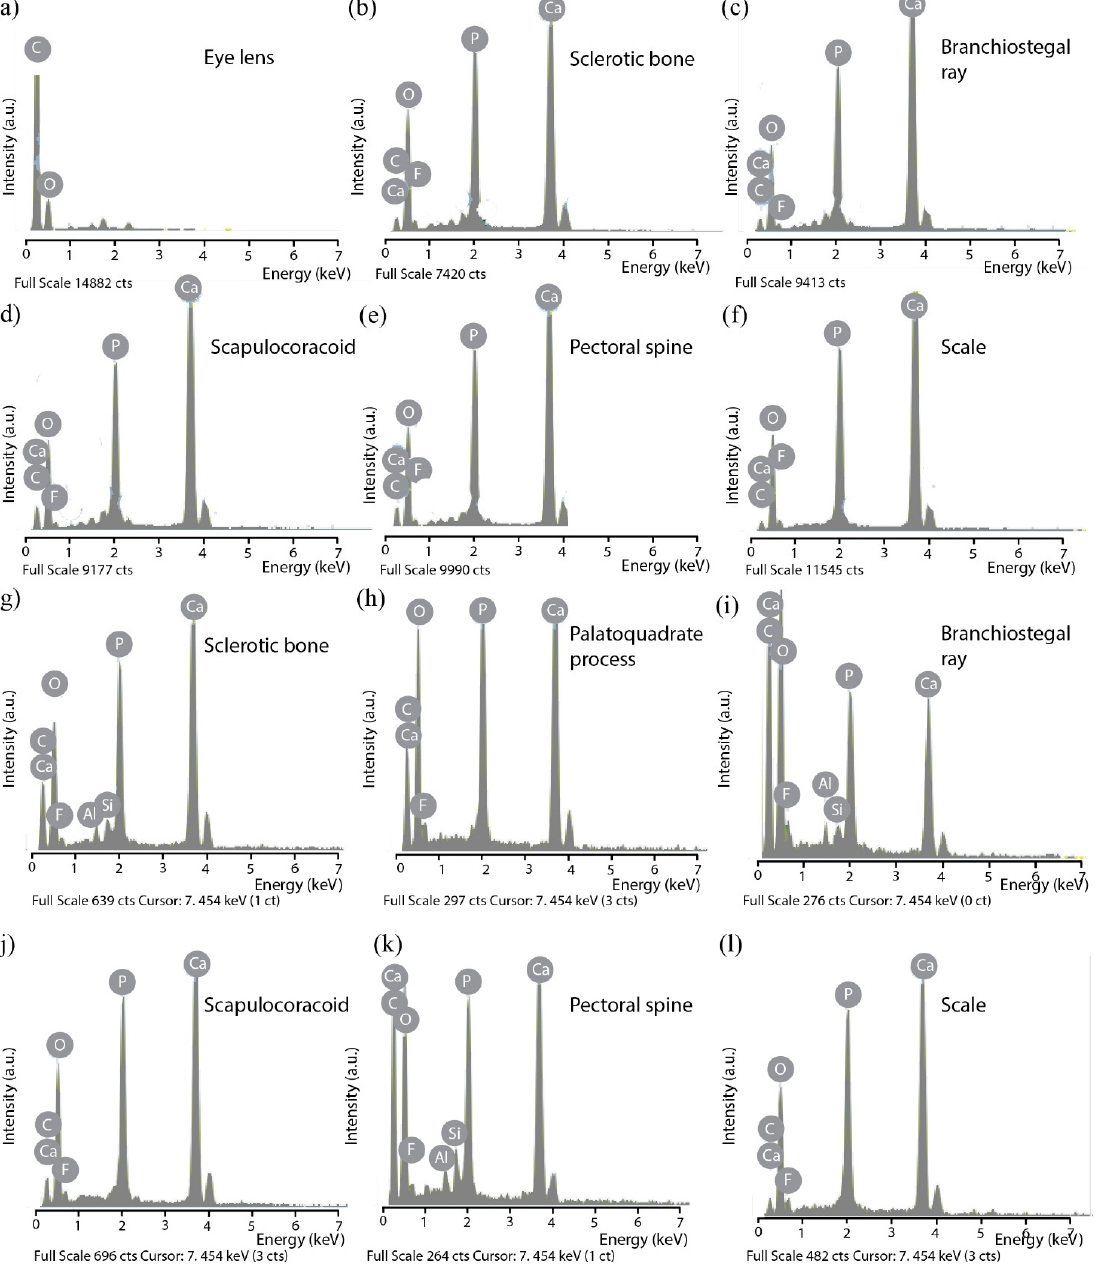
Figure 5. Representative spectra of adult Triazeugacanthus samples using EDX punctual microanalysis. ( a )–( f ) MHNM 03-2669. ( g )–( l ) MHNM 03-1497. Note that the intensity of the oxygen peak is non-significant and depends essentially on the vacuum level in the chamber of the environmental SEM. See Figure 3 for chemical elements legend.